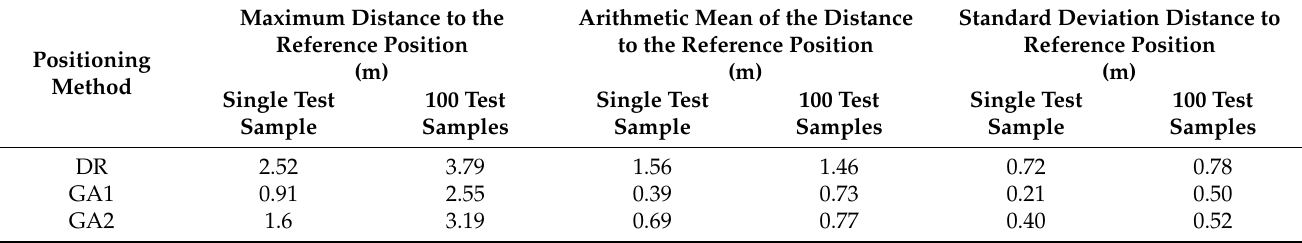
Table 3. Statistical parameters describing the change of distance to the reference position from positions estimated using the DR, GA1, and GA2 methods.